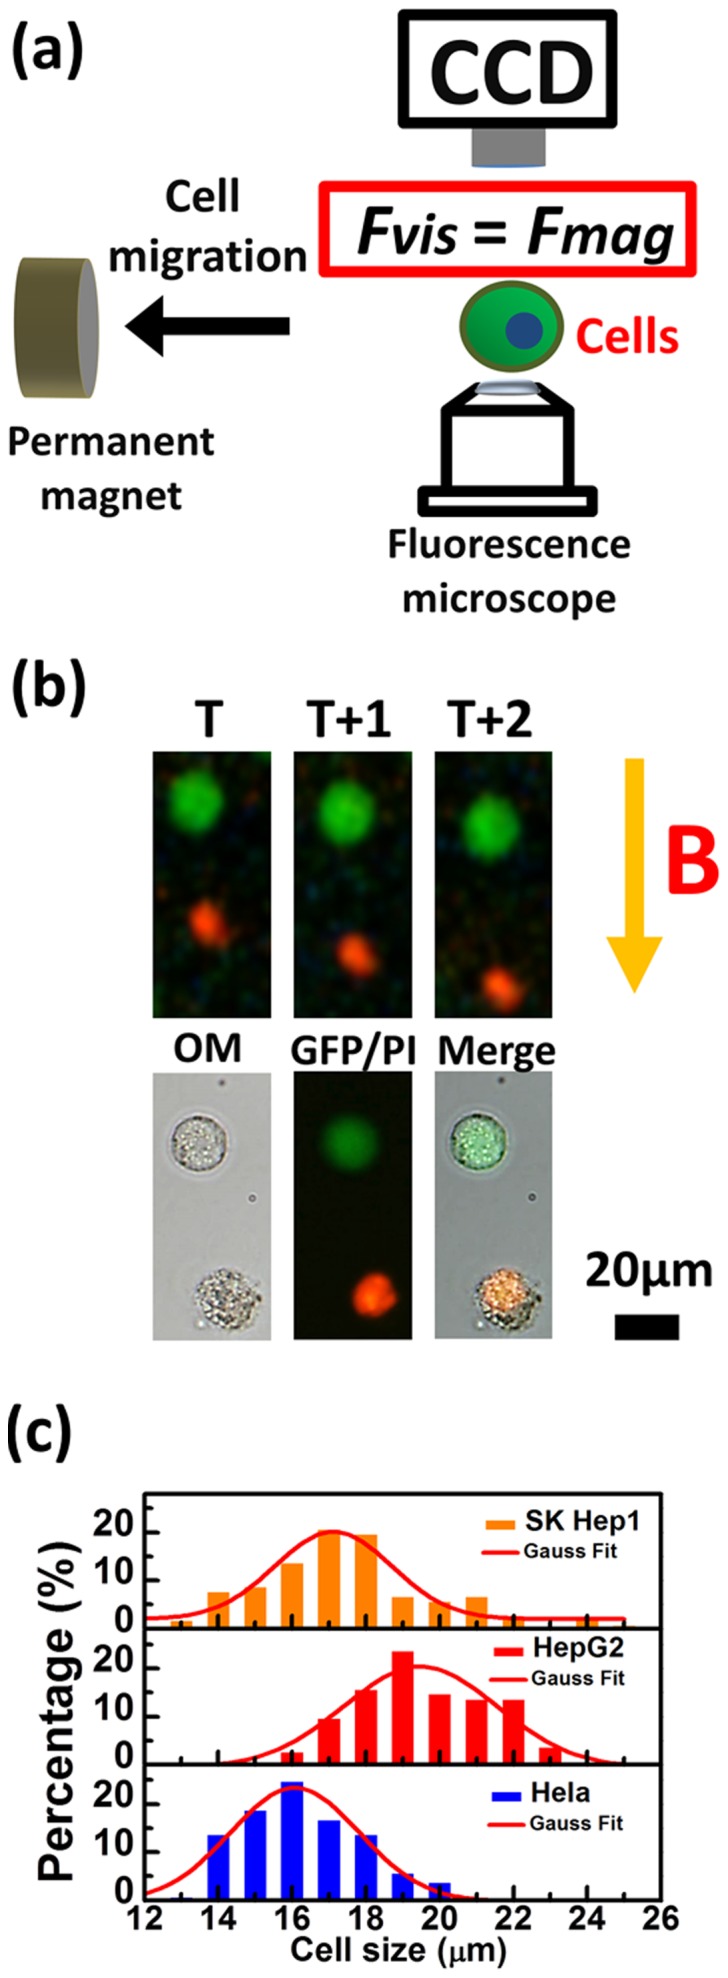
Magnetophoresis and living cell imaging.(a) Schematic representation of cell magnetophoresis. Fmag and Fvis indicate the magnetic force and the viscous force. (b) (Top) Consecutive magnetophoresis images of two cells move at constant speed (Bottom) Fluorescence image, optical microscope image and the merged image of the two cells. Green, live cells expressed green fluorescent protein (GFP); Red, nucleic acid stained by propidium iodide (PI). The scale bar represents 20 µm. (c) Size distributions of distinctive cells (SKHep-1, HepG2 and HeLa). The red lines are the standard normal distribution. N = 200 cells.